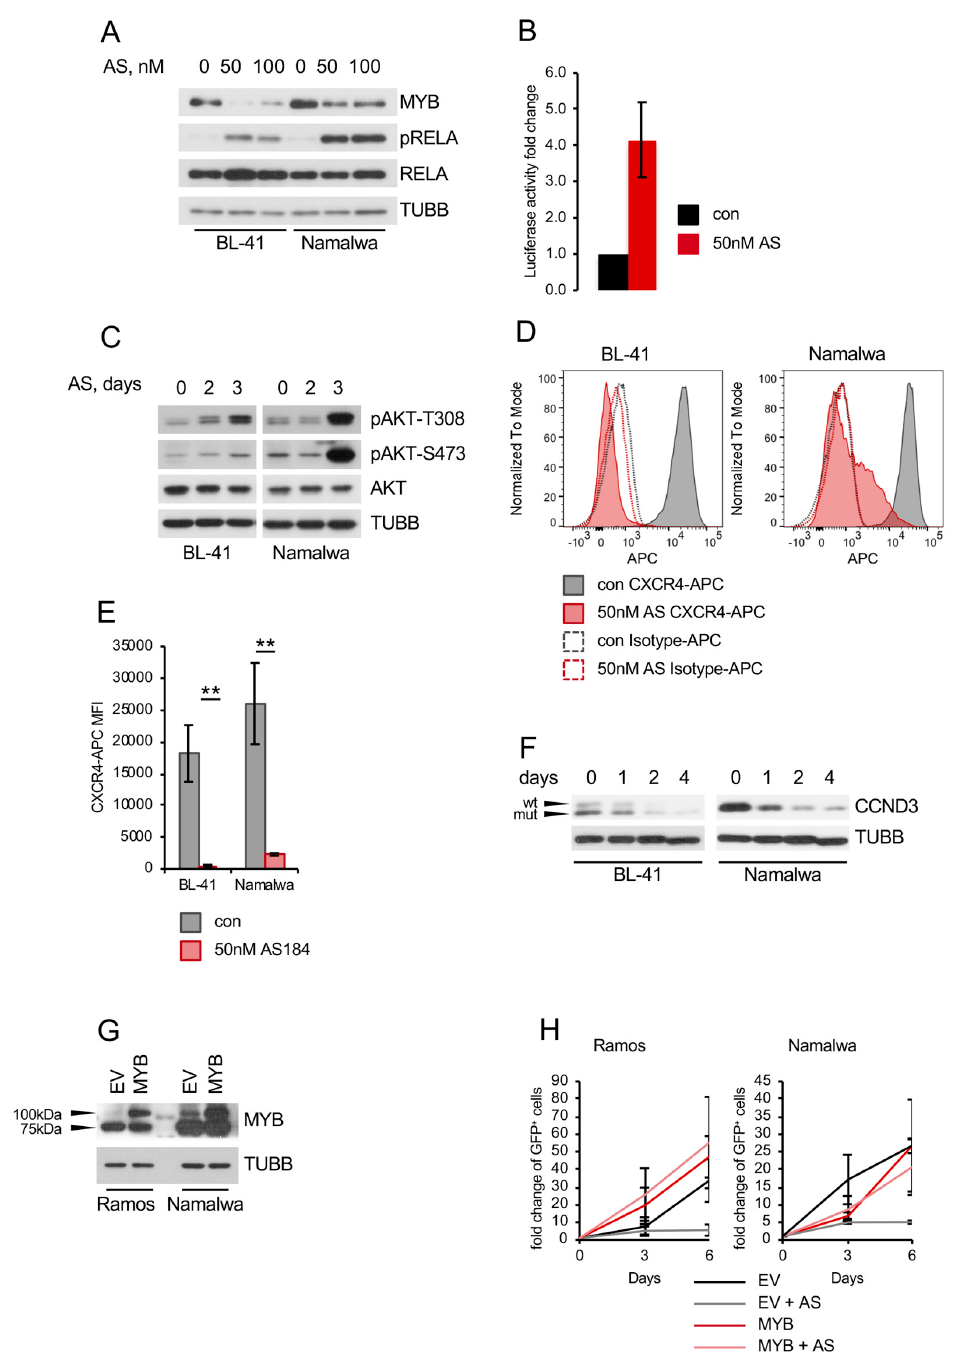
Figure 5. AS1842856 treatment mimics genetic FOXO1 inhibition. ( A ) Immunoblot showing reduced MYB and increased pRELA S536 levels after AS treatment for 4 days compared to DMSO-treated cells. TUBB served as loading control. Same loading control as in Figure 4B was used, since the same membrane was probed. A representative of 3 independent experiments is shown. ( B ) Luciferase reporter assay using the Namalwa cell line stably expressing a NF- κ B-dependent luciferase reporter (3 × κ B.luc) [41]. Cells were treated with 50 nM AS for 3 days followed by cell lysis. Luminescence was measured as described in Supplemental Methods. Data are shown as mean ± SD ( n = 3). ( C ) Immunoblot showing pAKT T308 and pAKT S473 levels after 2 and 3 days of AS treatment compared to DMSO-treated cells. TUBB served as loading control. A representative of 2 independent experiments is shown. ( D , E ) AS downregulates CXCR4. BL cell lines were treated for 4 days with 50 nM AS or DMSO. Treated cells were stained with CXCR4-APC or isotype control. ( D ) FACS histogram plots of stained cells.